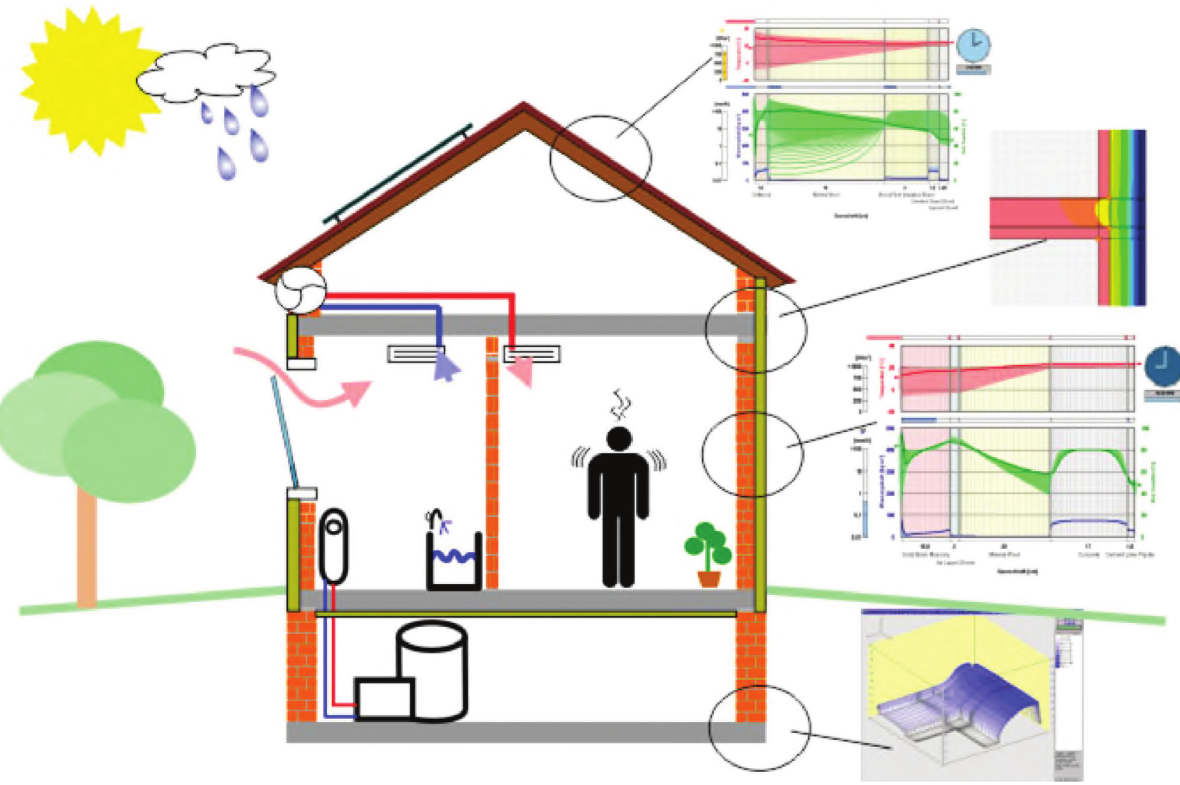
Schematic representation of building simulation models including not only thermal but also moisture transfer simulations for all relevant envelope components including transient thermal bridge calculations and considerations of transient HVAC performance as well as building operation modes and the behaviour of occupants [43]. The figure demonstrates the impacts of human activity and HVAC systems on the indoor climate and the hygrothermal interactions with the different envelope component simulations. Thus, the moisture buffering effect of the building envelope and the hygrothermal performance of envelope components can be accurately